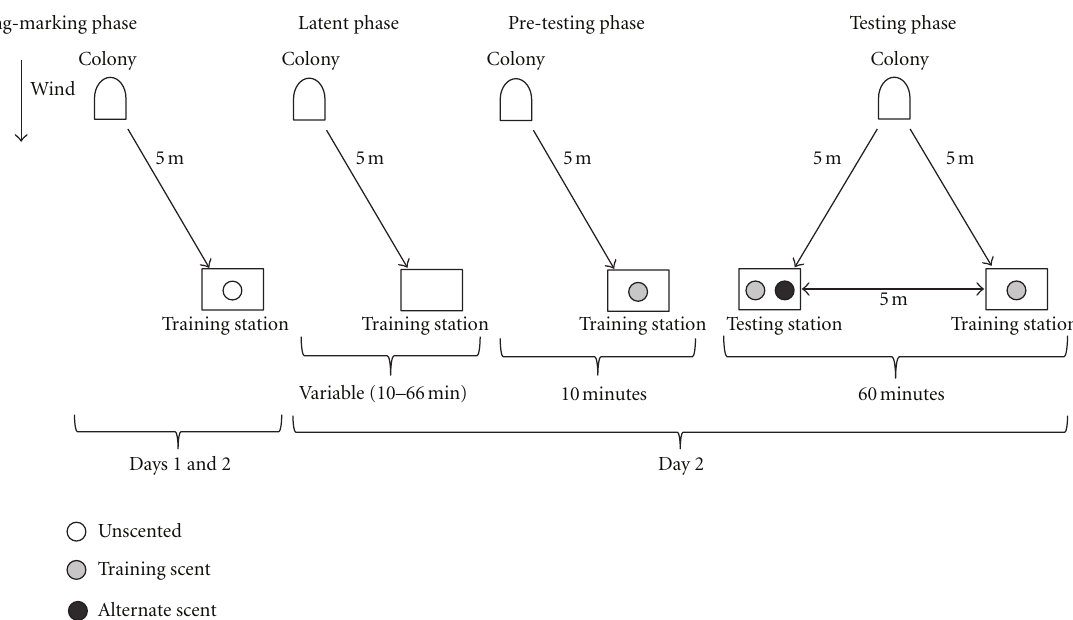
Figure 1: Experimental set-up and procedure. Prevailing wind direction is